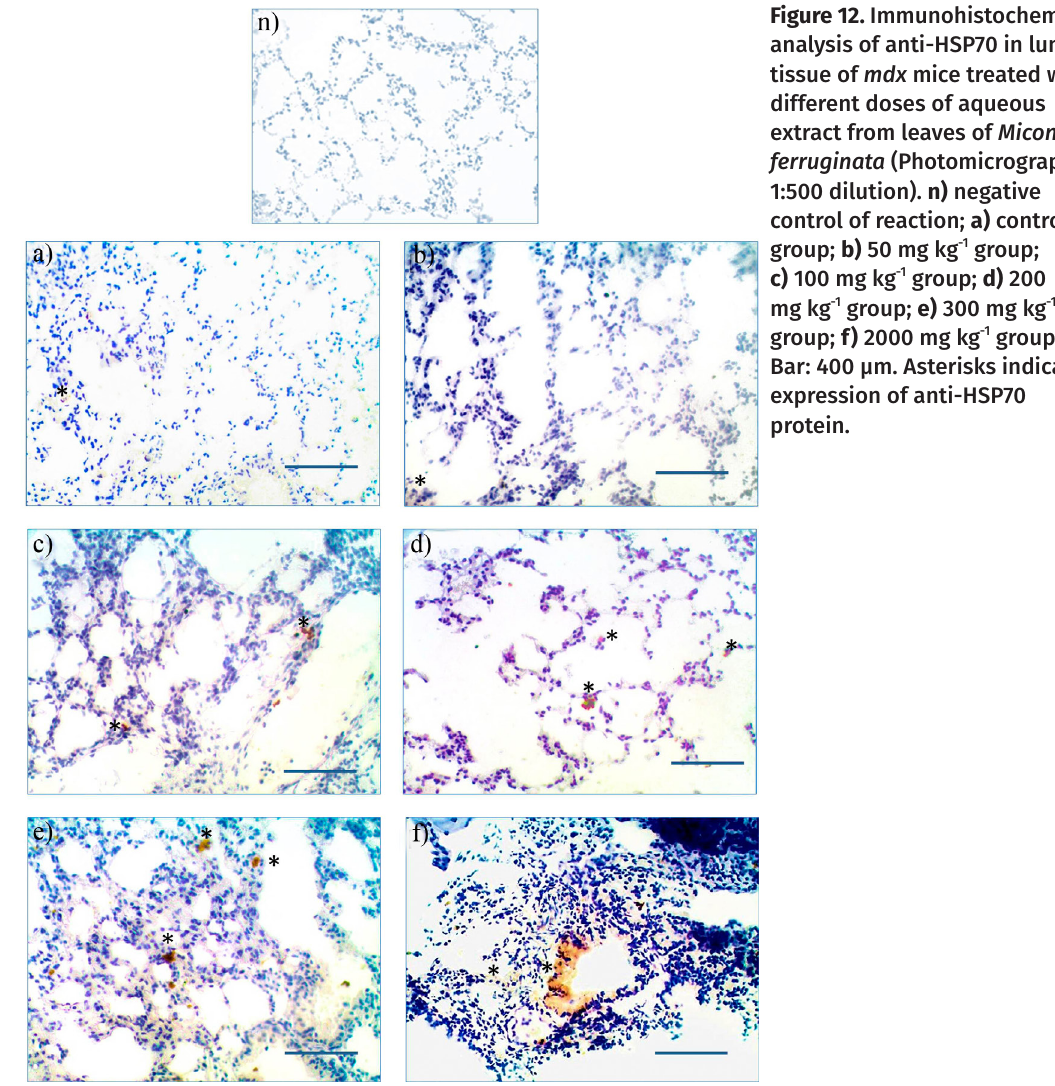
Figure 12. Immunohistochemical analysis of anti-HSP70 in lung tissue of mdx mice treated with different doses of aqueous extract from leaves of Miconia ferruginata (Photomicrography, 1:500 dilution). n) negative control of reaction; a) control group; b) 50 mg kg -1 group; c) 100 mg kg -1 group; d) 200 mg kg -1 group; e) 300 mg kg -1 group; f) 2000 mg kg -1 group. Bar: 400 µm. Asterisks indicate expression of anti-HSP70